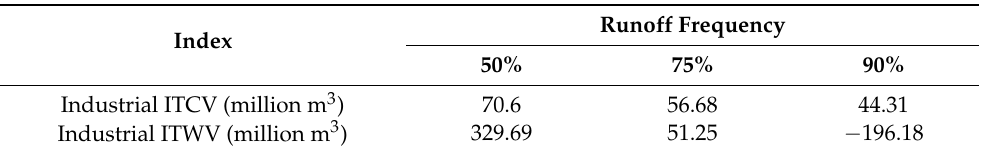
Table 10. The ITWV and the ITCV of industry in Changsha city in 2030 under different runoff frequencies.